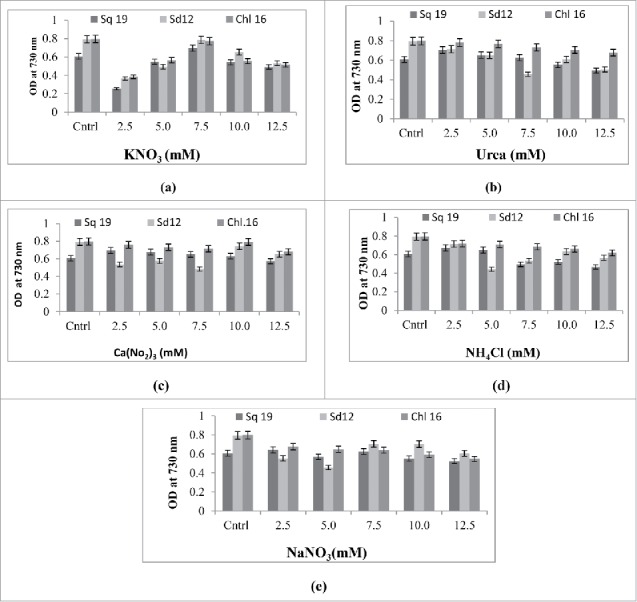
Growth responses of S. quadricauda (sq 19), S. dimorphus (sd 12,) and Chlorella sp (Chl 16) isolates (after 18th day) at OD at 720 nm in modified BG-11 medium supplemented with (A) KNO3 (B) Urea (C) Ca(NO3)2 (D) NH4Cl (E) NaNO3· All values are represented as ± s.d of 3 replications.